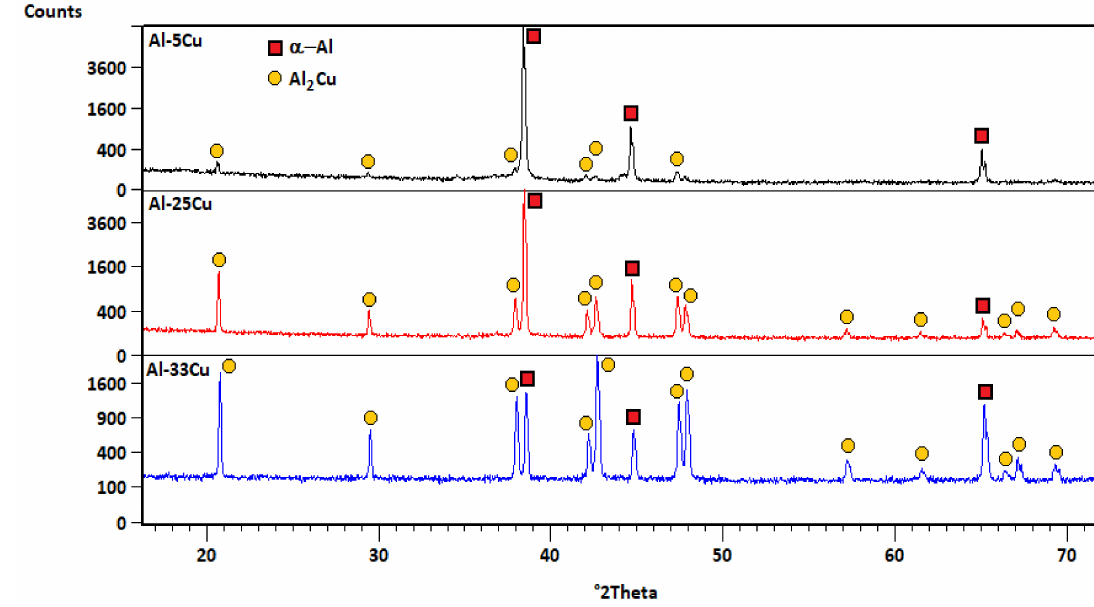
Figure 2. X-ray di ff raction patterns of Al–Cu alloys.